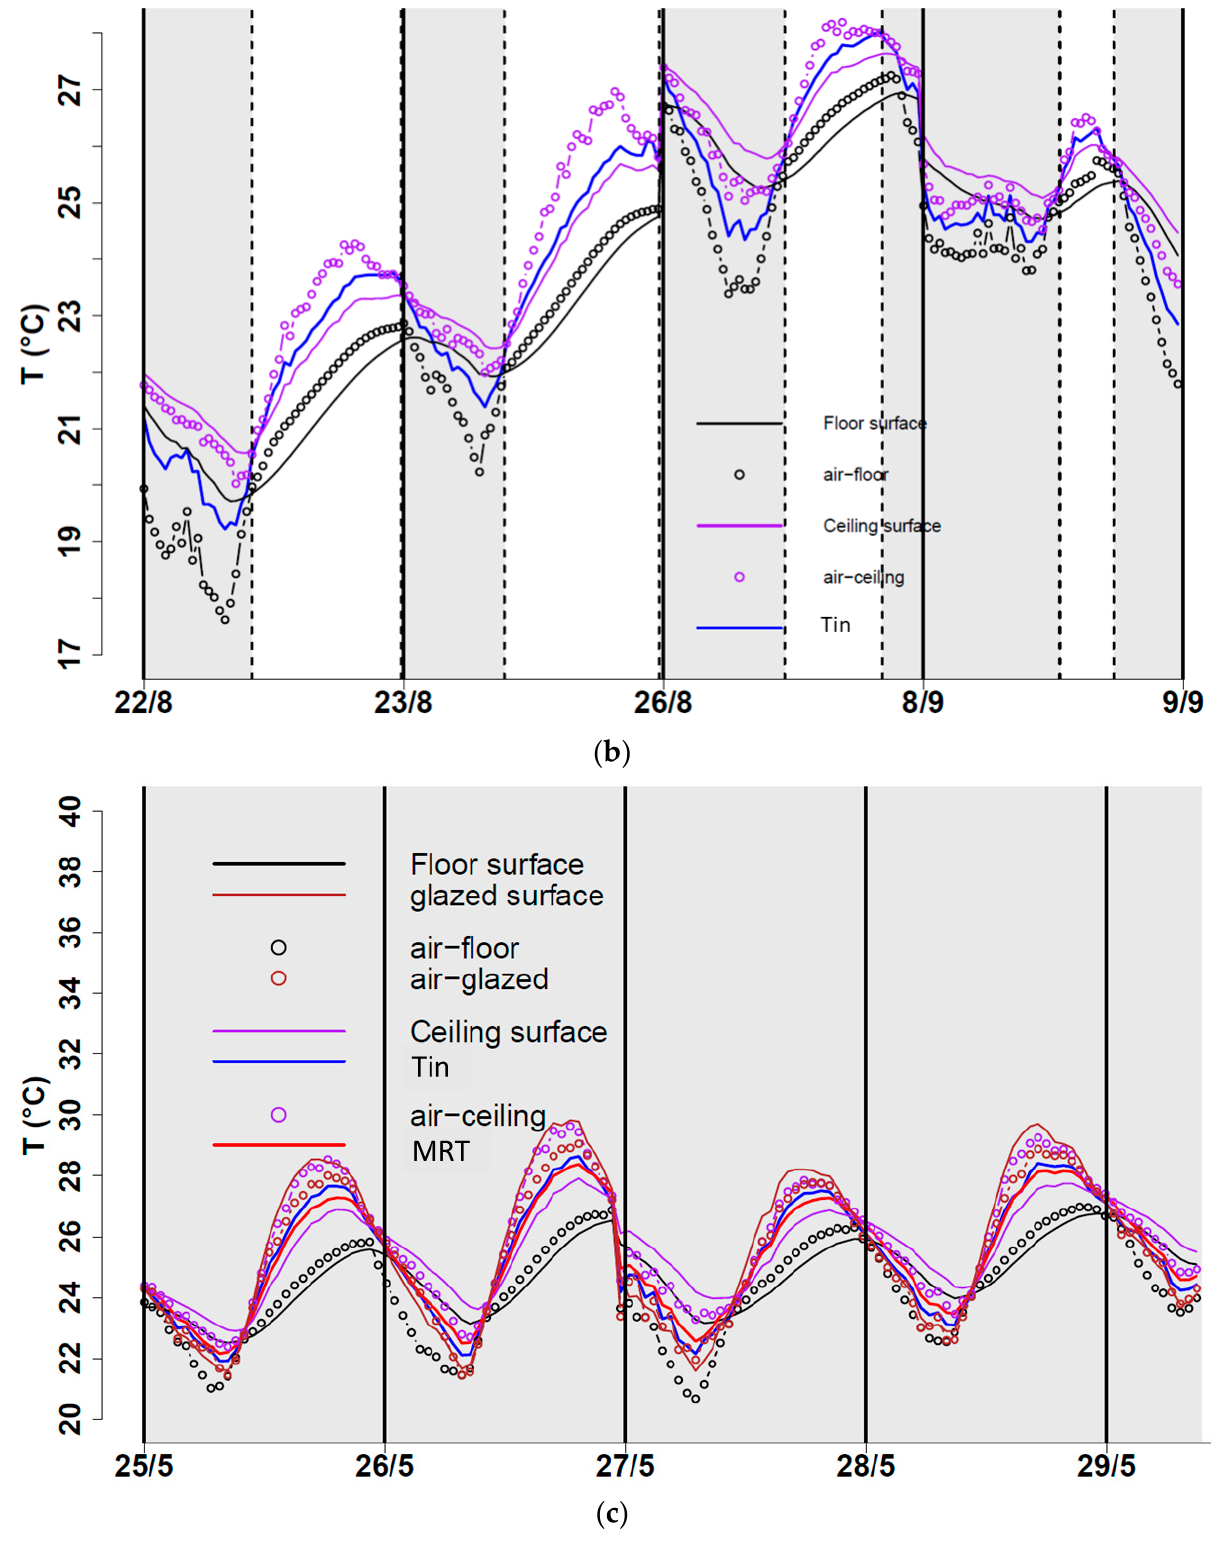
Figure 7. Air and surface-air temperatures for: ( a ) config. #1, ( b ) config. #2, and ( c ) config. #3.